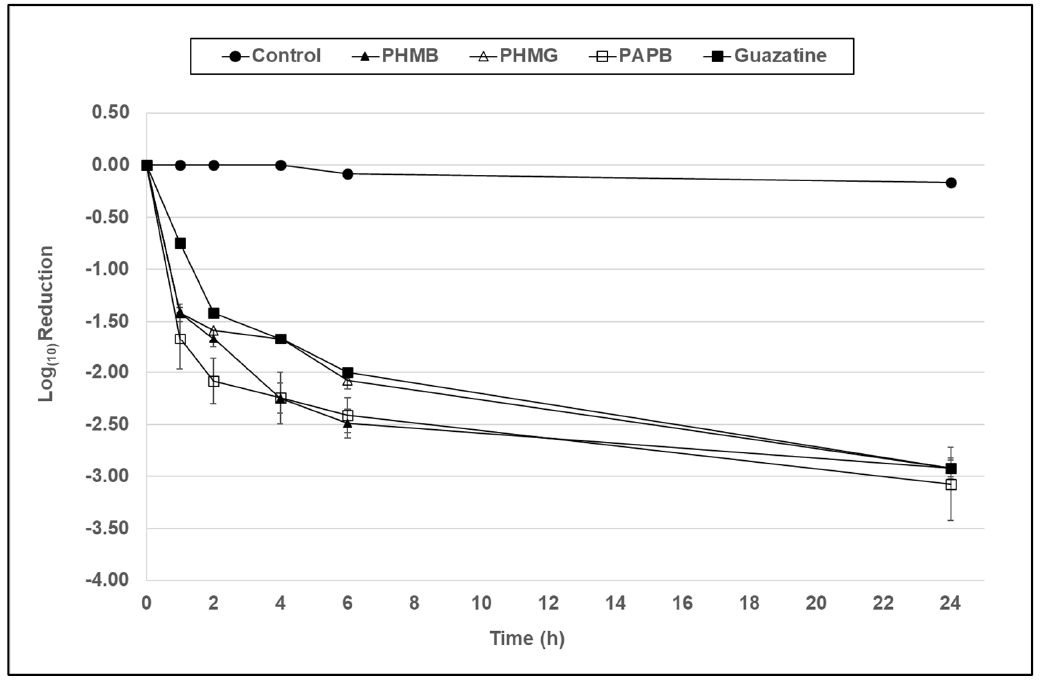
Figure 1. The antimicrobial activity of PHMB, PHMG, PAPB, and guazatine against A. polyphaga (ATCC 30461) trophozoites over a 24 h period at a concentration of 7.8 µg/mL formulated in a con- tact lens base solution. Error bars show the standard error of the mean (SEM) from triplicate exper- iments.